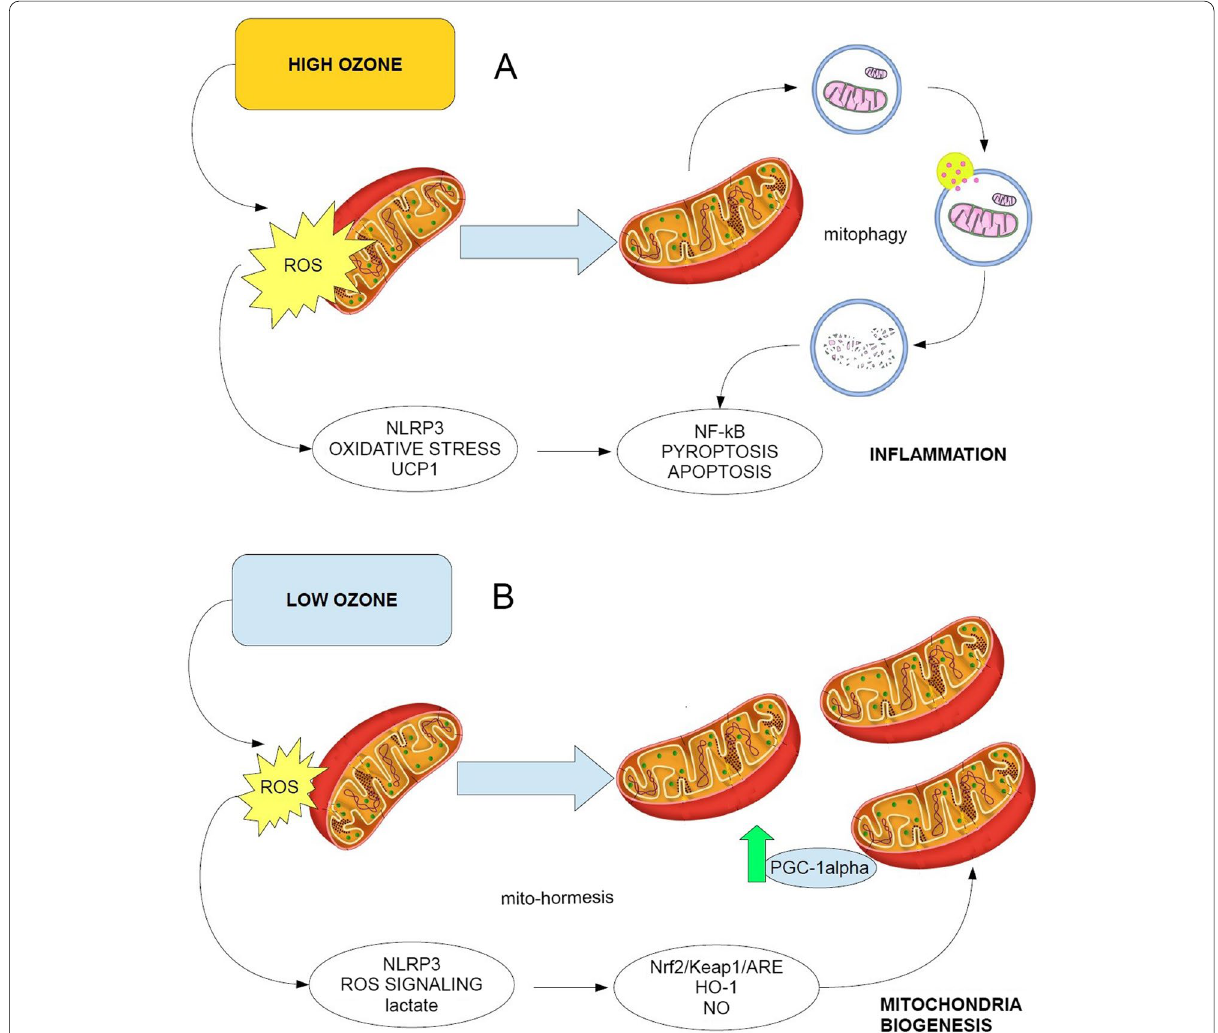
Fig. 1 The different action of ozone on mitochondria. A High doses of ozone activate a huge ROS response, mitophagy and the shift of the Nrf2/ NF-κB rate towards NF-κB, finally leading to an inflamed state even with pyroptosis and apoptosis; B Low doses of ozone, slightly activating the NLRP3 via ROS as signaling molecules, increase the rate Nrf2/NF-κB, triggering an anti-oxidant state and inducing mitochondria biogenesis